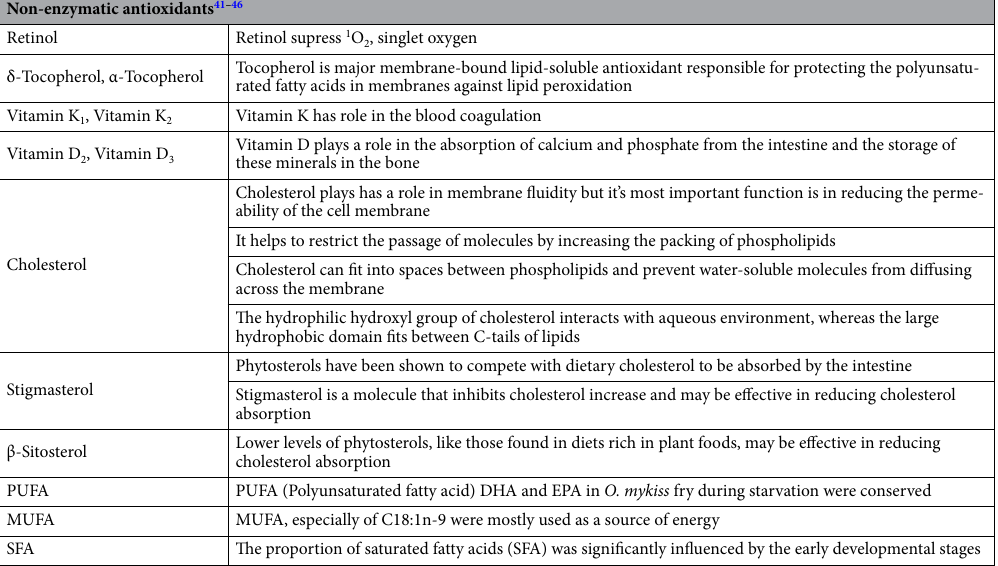
Table 5. Oxidative stress and antioxidant defence markers. The role of each molecules studied. Non enzymatic antioxidant scavenging systems that maintain endogenous reactive oxygen species (ROS) at relatively low